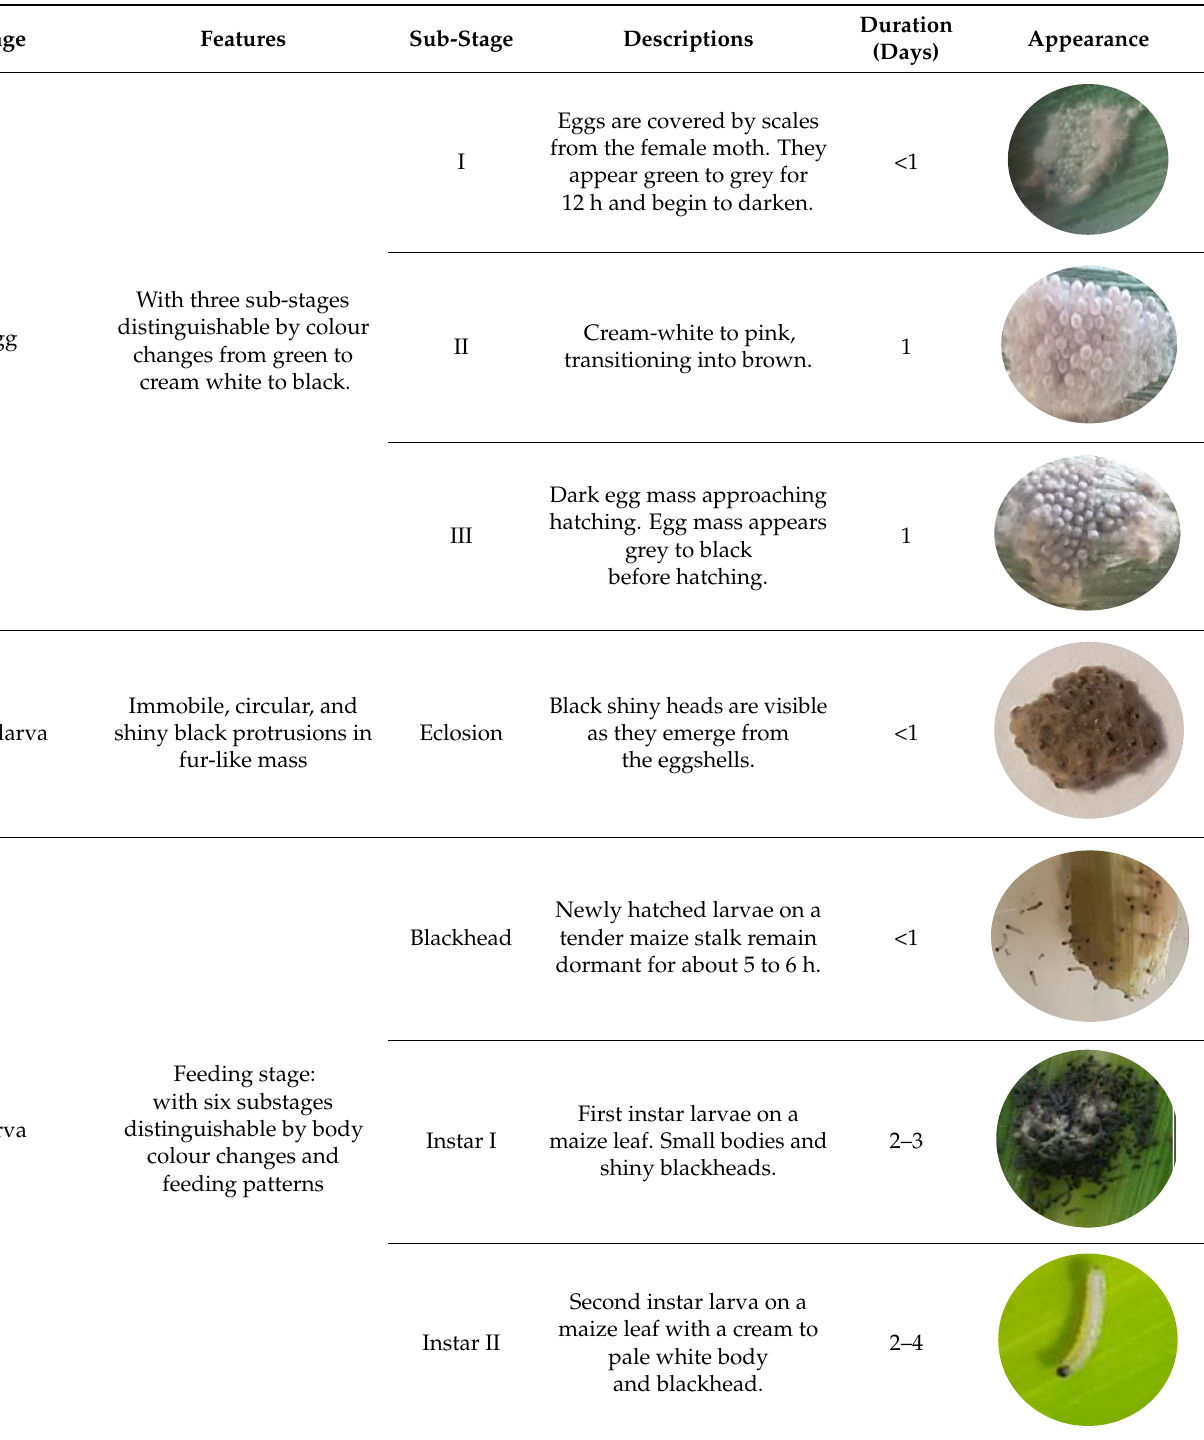
Table 6. Description of the developmental stages of FAW on maize leaf under controlled laboratory conditions in Zambia.